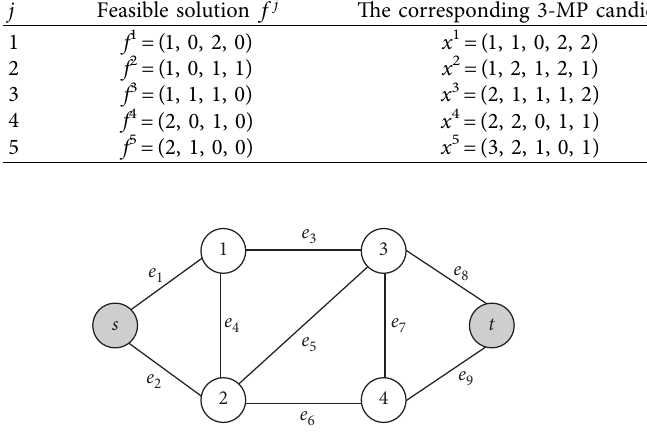
Figure 3: A test network for example 1. Table 3: Results of different algorithms for solving the network in Figure 3.